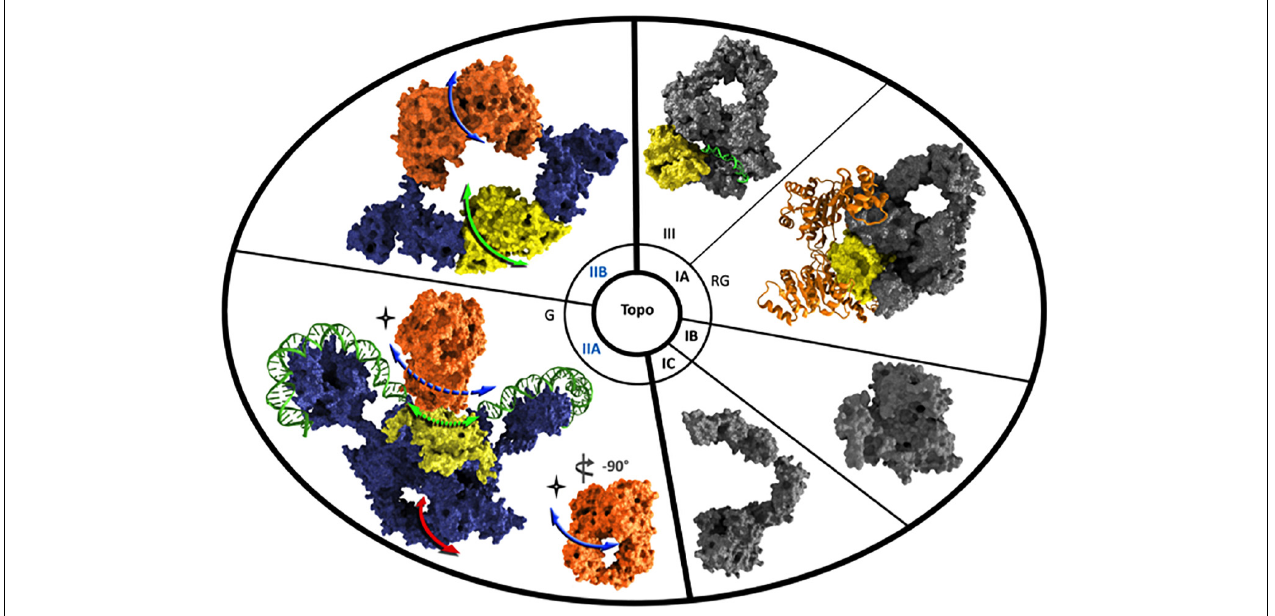
FIGURE 4 | Structural schematic view of the different types of DNA-topoisomerases. The 3-D structures of representative type I and type II DNA-topoisomerases are shown. Key domains such as ATPase domain and Toprim domain are highlighted in orange and yellow, respectively. SF2 helicase-ATPase domain in reverse gyrase is represented by an orange ribbon. DNA molecules are colored in green. Topo IIA is exemplified by gyrase and DNA is all around the ß-pinwheel structure and through the DNA-gate (green arrows) located within the Toprim domain. A perpendicular view of ATP-binding domain allows to show the ATP-gate (blue arrows) as a hole in comparison with the C-gate (red arrow) hole visible in the lower part of the carboxy-terminal domain in blue. The full and dashed arrows outline the direct and indirect visualization of the DNA position during the passage through the DNA-gate, respectively. The 3-D structures have been visualized using Visual Molecular Dynamics and rendering with 3DS MAX. The PDB numbers used for these structures are 3PX7 (Zhang et al., 2011), 4DDU (Rodríguez and Stock, 2002), 3M4A (Patel et al., 2010), 5HM5 (Rajan et al., 2016), 6RKW (Vanden Broeck et al., 2019), and 2Q2E (Corbett et al., 2007), and they refer to Topo III (noted as III), reverse gyrase (noted as RG), Topo IB, Topo IC, Gyrase (noted as G), and Topo IIB,